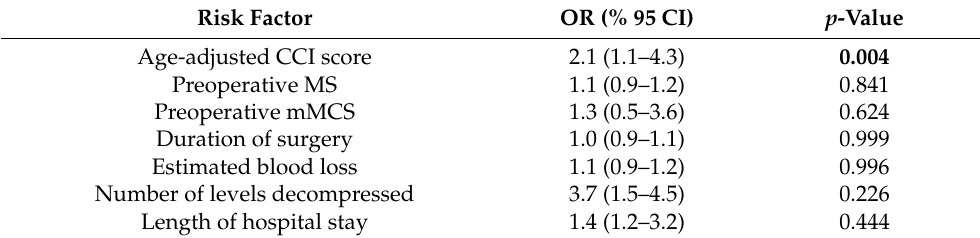
Table 5. Risk factors associated with the occurrence of